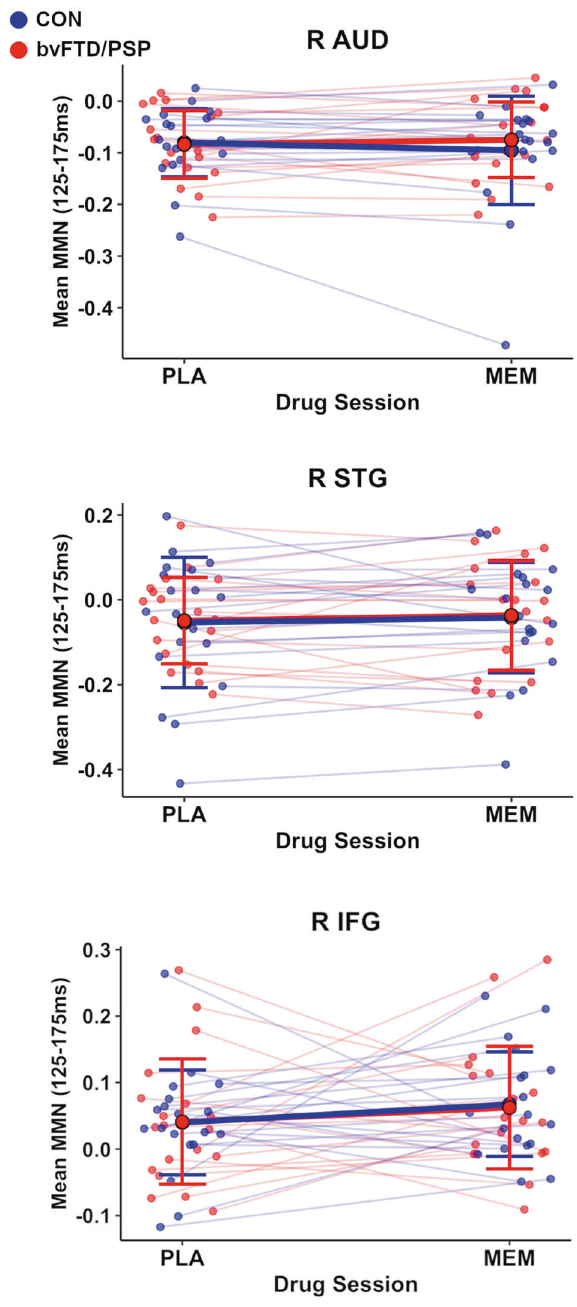
Fig. 3 Group responses to memantine across controls and persons with PSP and bvFTD. Mean MMN response across placebo (PLA) and memantine (MEM) drug sessions for controls (blue circles and lines) and FTLD (red). Mean group responses at each drug session are indicated by bold circles, with error bars representing 95% con fi dence intervals. Group average change in mean MMN across drug session indicated by solid lines, with each participants slope illustrated by opaque lines. R IFG right inferior frontal gyrus, R STG right superior temporal gyrus, R AUD right auditory cortex, bvFTD behavioural variant frontotemporal dementia, PSP progres- sive supranuclear moderated by prefrontal GABA. In other words, the mismatch between incoming deviant auditory signals with the predicted standard tone is larger on memantine in the context of (near) normal prefrontal GABA.